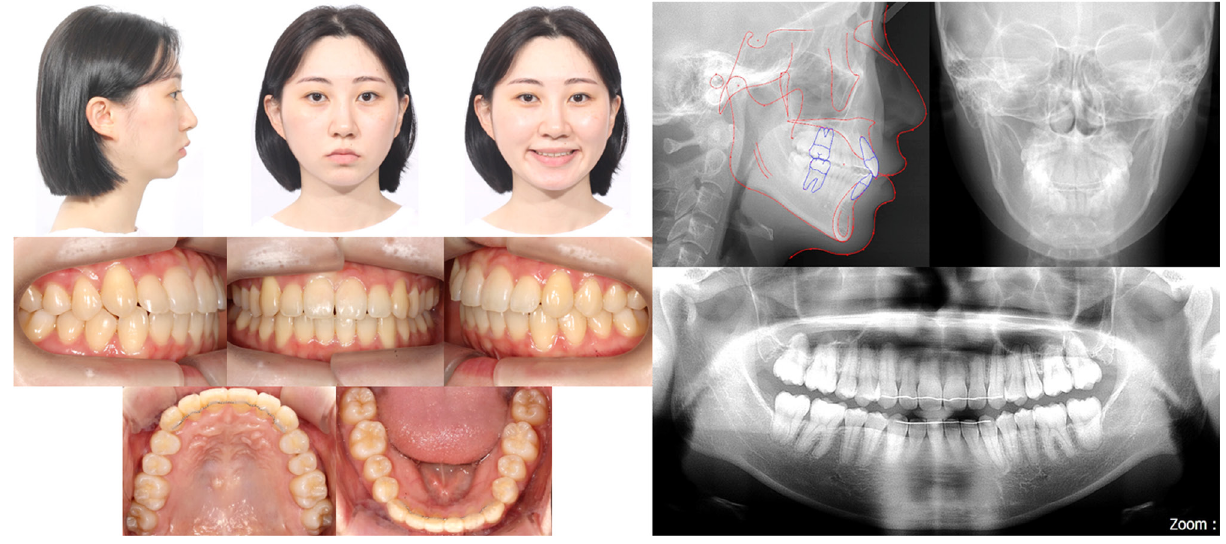
Figure 8. Post-treatment photographs and radiographs at 12